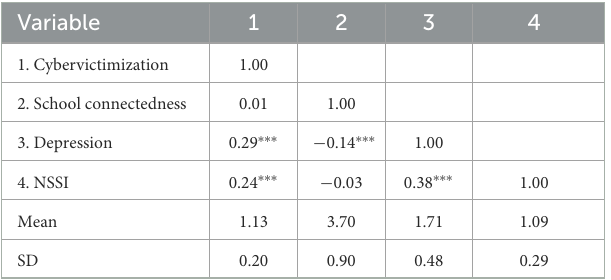
TABLE 1 Descriptive statistics and correlations for all variables.